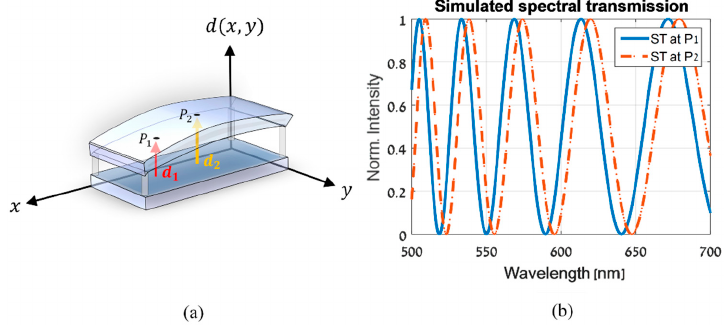
Figure 1. ( a ) A demonstration of a spatially non-uniform LCC. The cell gap ( ) , d x y changes